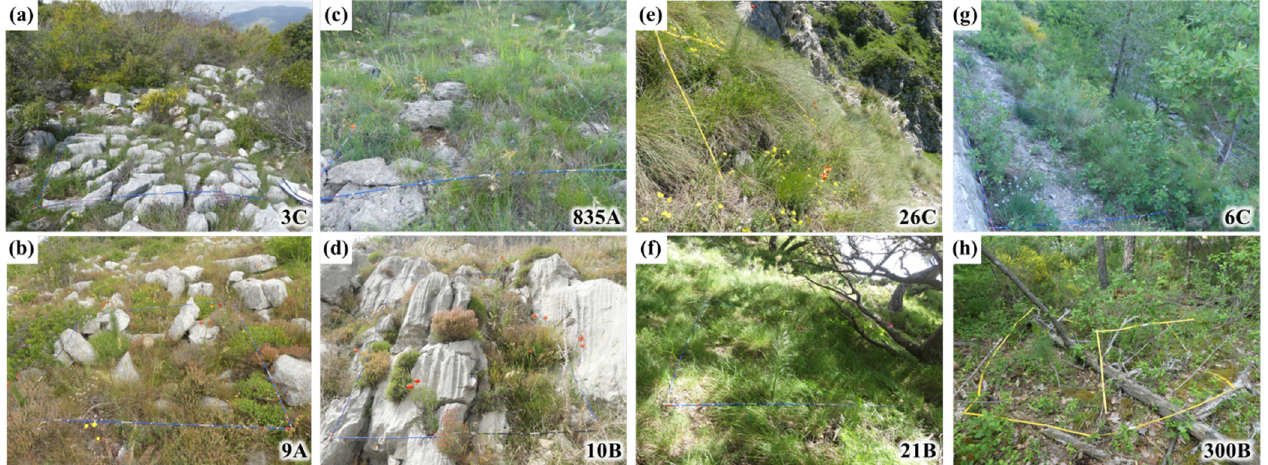
Figure 5. Illustrations of the four different niche types of Lilium pomponium : ( a , b ) niche type 1, ( c , d ) niche type 2, ( e , f ) niche type 3, ( g , h ) niche type 4. Upper line ( a , c , e , g ) corresponds to the typical quadrats closest to the cluster centre in the MFA, lower line ( b , d , f , h ) to the typical quadrats furthest from other clusters.